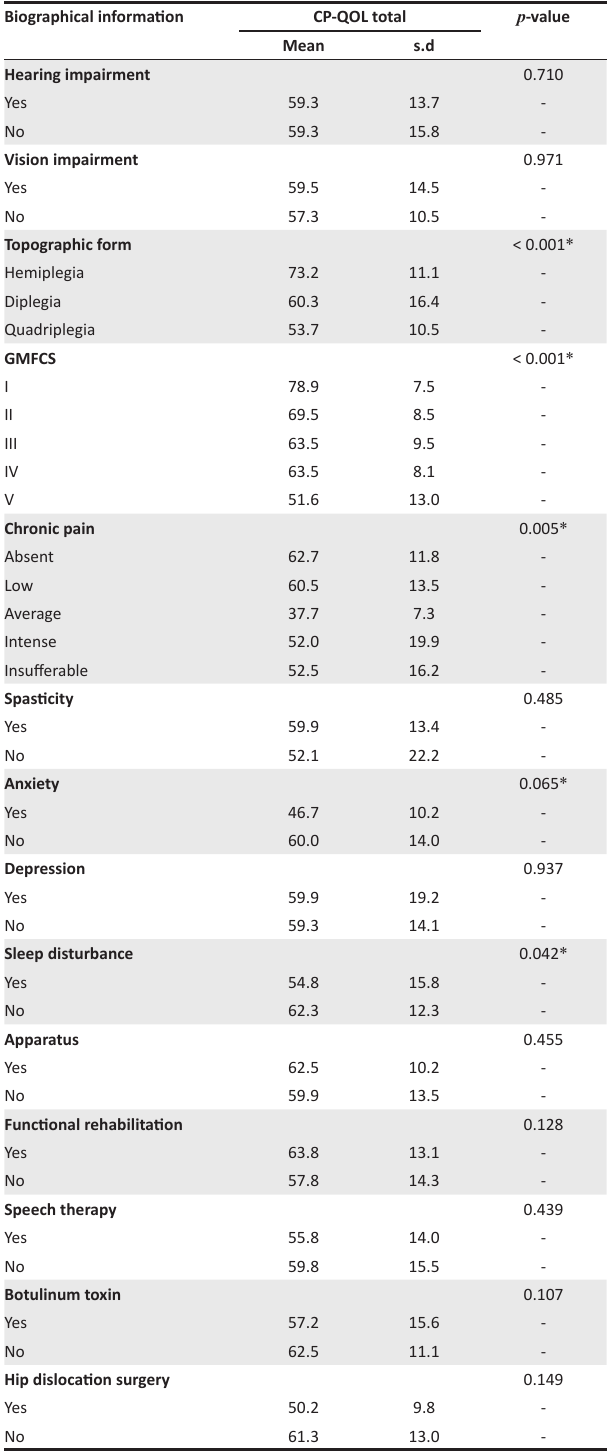
TABLE 4 (Continues...): Relationship between quality of life in children with cerebral palsy and socio-demographic, economic, clinical and therapeutic information.